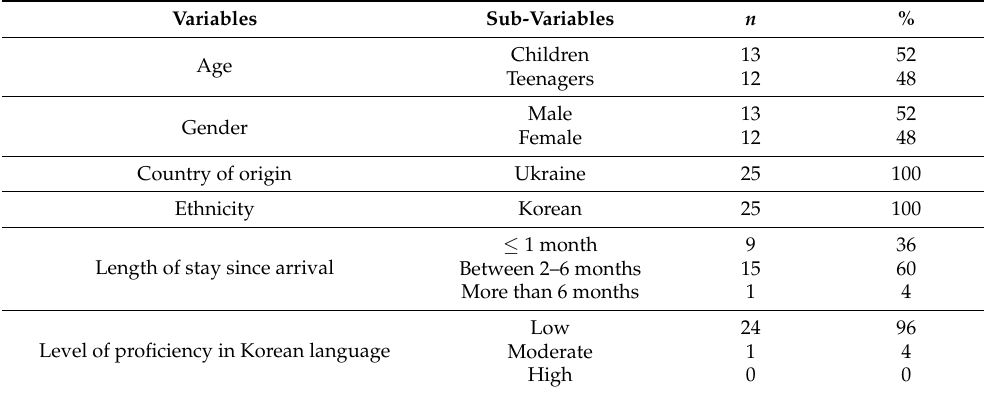
Table 1. Demographic characteristics of participants.